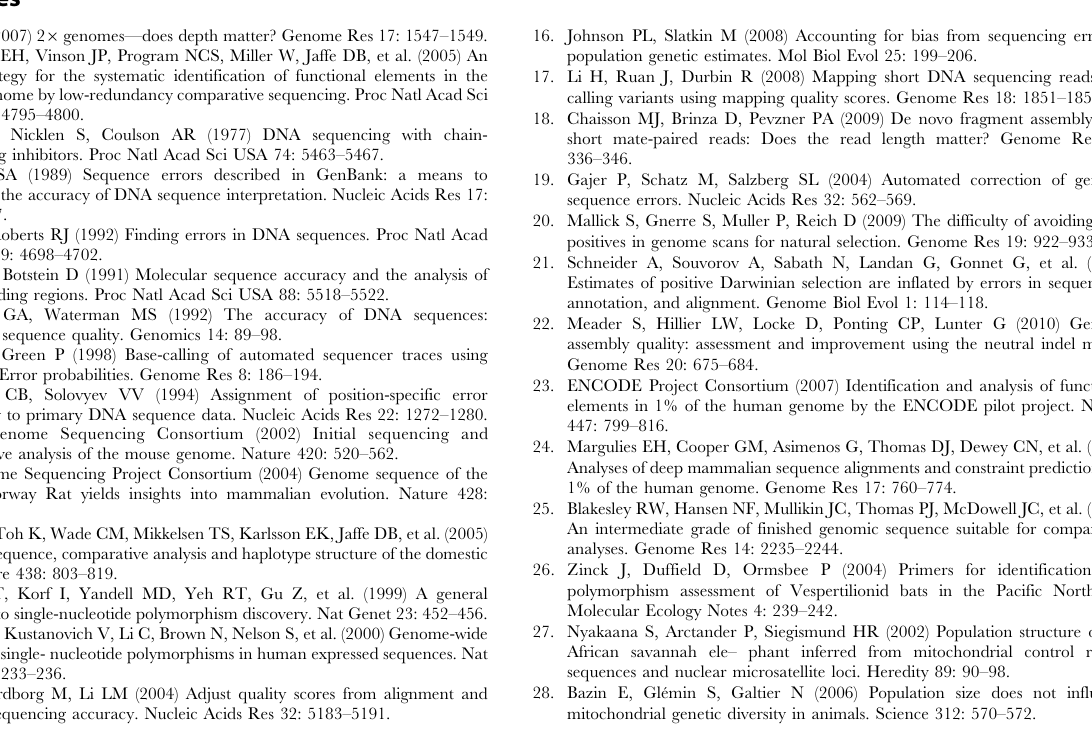
Table S5 CONGO performance by